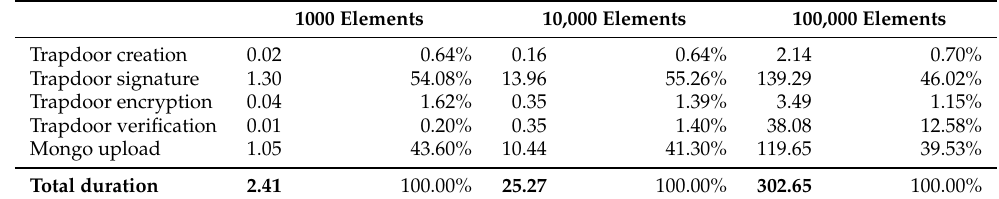
Table 3. Shared index update process duration with cache—results (in seconds and percentages).